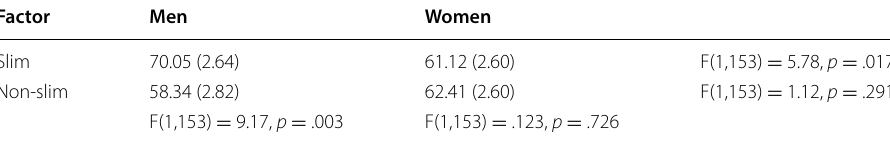
Table 2 Pairwise comparisons on respondents’ favorability in dependence on respondents’ gender or